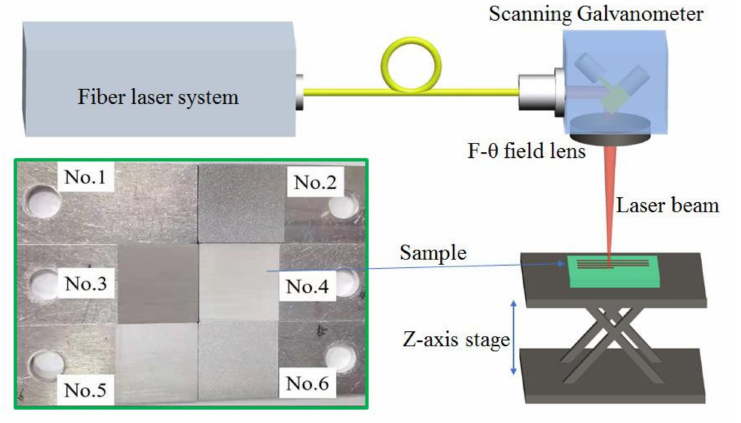
Figure 2. Experiment setup for laser surface treatment. The inset showed pictures of Al alloy samples before treatment (No.1), after sandblasting (No.2) and laser surface treatment (No.3–No.6).